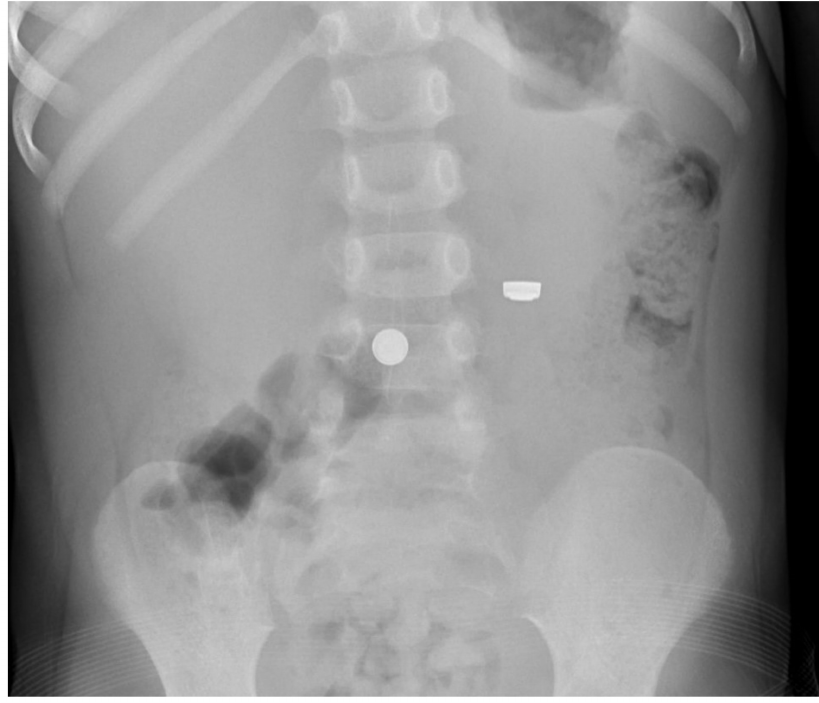
Figure 4. Abdominal radiograph of a child showing swallowed button batteries in two different